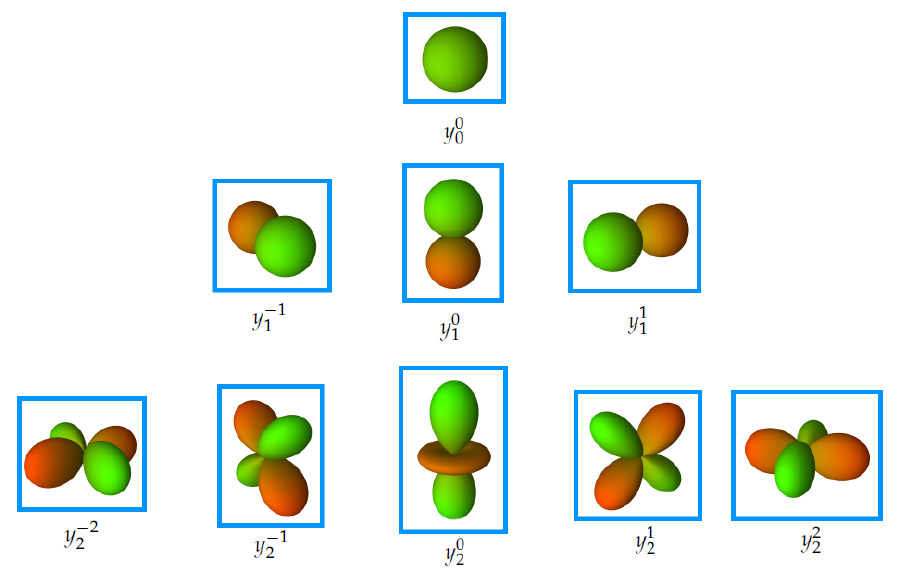
Figure 6. Illustration of the real valued spherical harmonic basis functions, where green means positive values and red is associated with negative